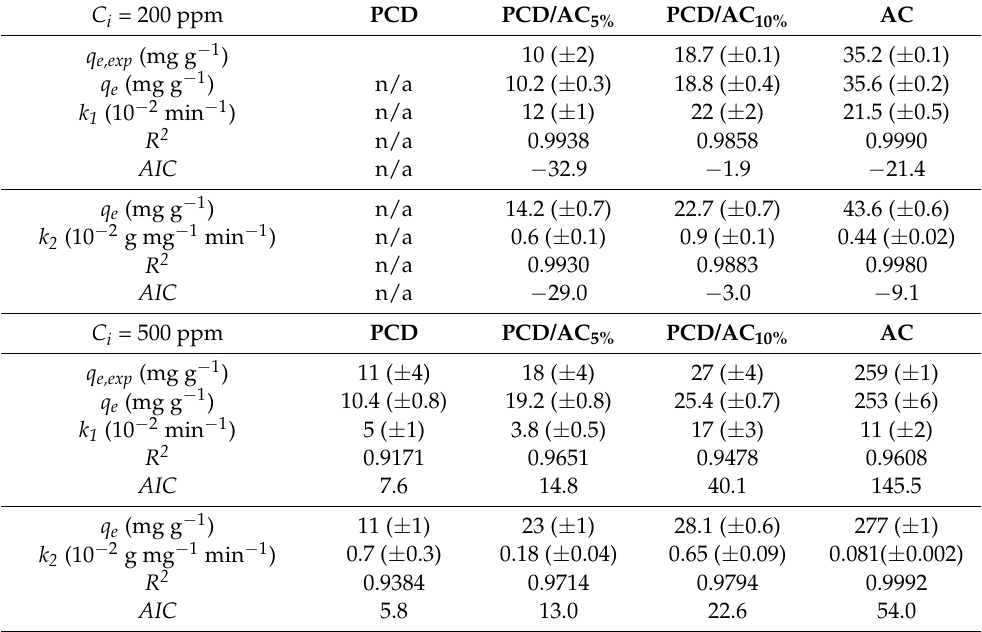
Table 4. Fitting parameters for the fitting of pseudo-first order (up) and pseudo-second order (down) kinetic equations for the sorption of cymoxanil, at 25 ◦ C and 200 and 500